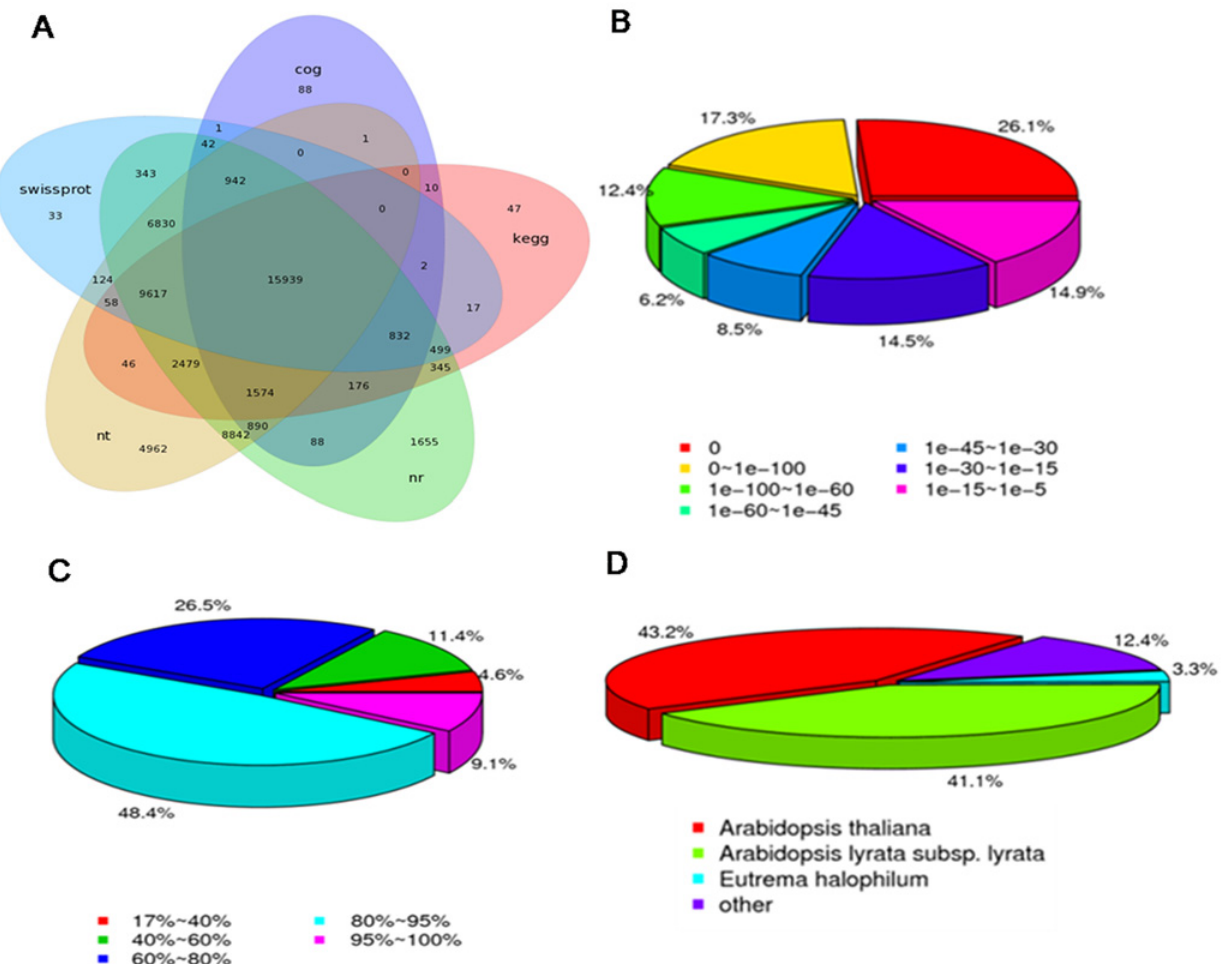
Fig 3. Unigenes annotatation and characteristics of homology search of unigenes against the nr database. A: Venn diagram of number of unigenes annotated by BLASTx with an E-value threshold of 10 -5 against the 5 databases. B: E-value distribution of the top BLAST hits against the nr database for each unique sequence. C: Similarity distribution of the top BLAST hits against the nr database for each unique sequence. D: Species distribution of unigenes in the nr